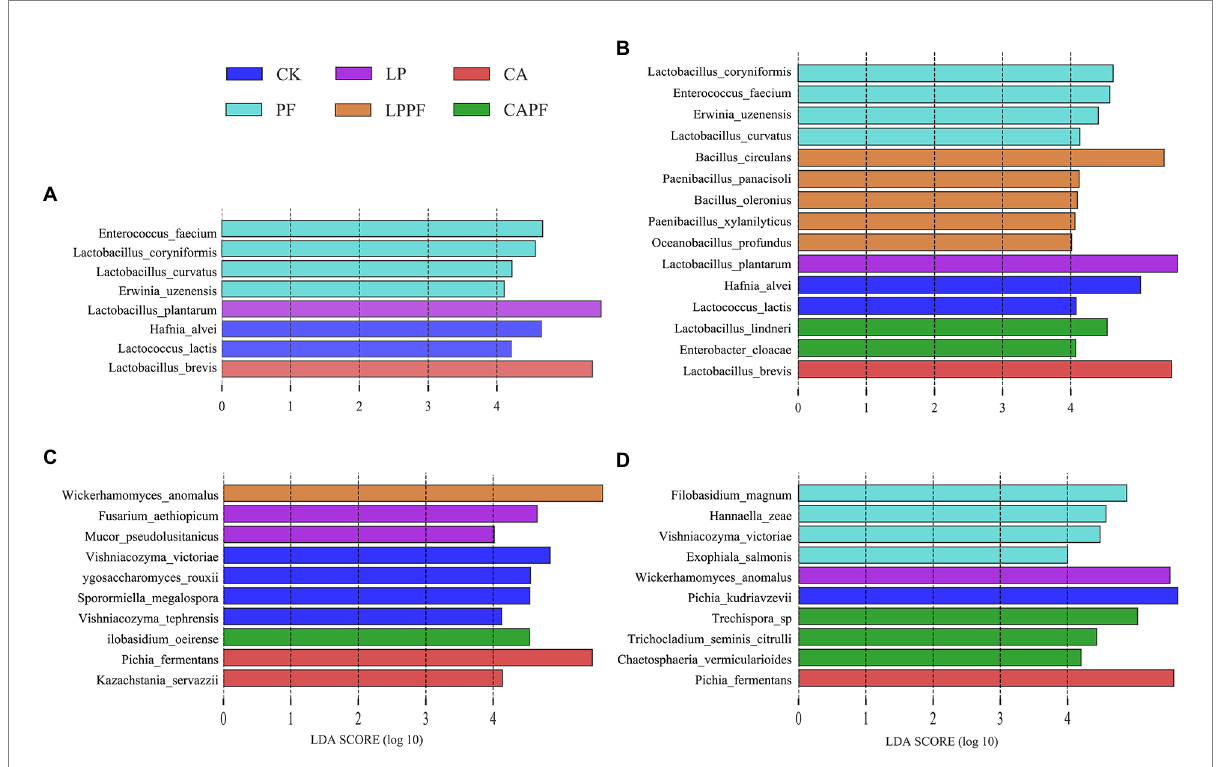
FIGURE 5 LEfSe analysis of bacterial and fungal variations in forage oat silages. Bacteria species level on 60-day of ensiling (A) , and 3 days of aerobic exposure (B) ; fungal species level on 60-day of ensiling (C) , and 3 days of aerobic exposure (D) . CK, control; LP, Lactobacillus plantarum a214; CA, citric acid; PF, purple perilla; LPPF, purple perilla + Lactobacillus plantarum a214; CAPF, purple perilla + citric